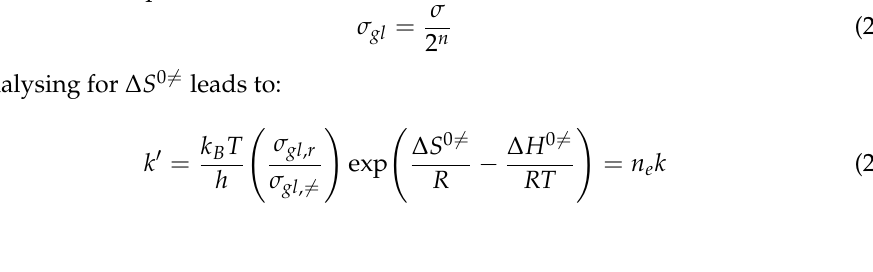
Figure 5. Some elementary steps of paraffins, olefins, naphthenes and aromatics in the FCC riser. (Adapted from [113]).